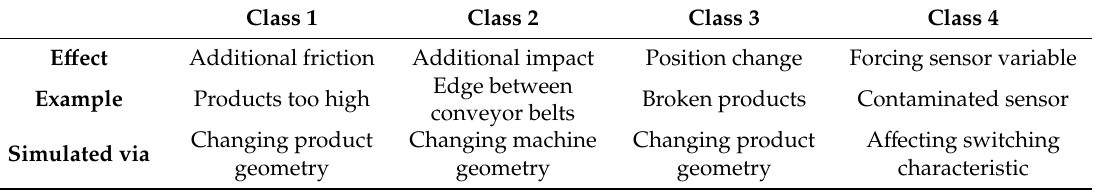
Table 1. Classification of disturbances representable within virtual commissioning (VC)